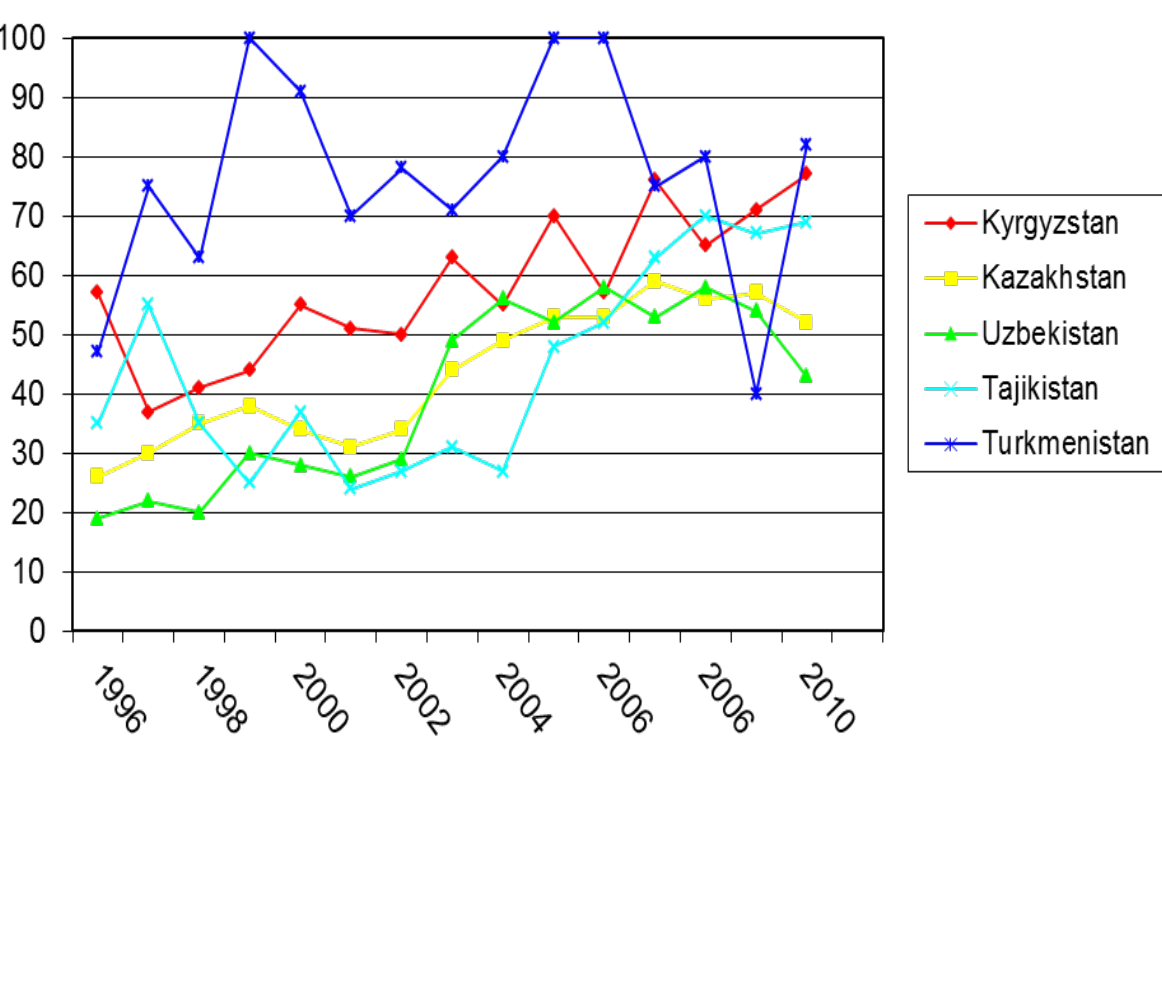
Figure 4: The percentage of articles written in the Central Asian countries which are written with a co-author from another country.